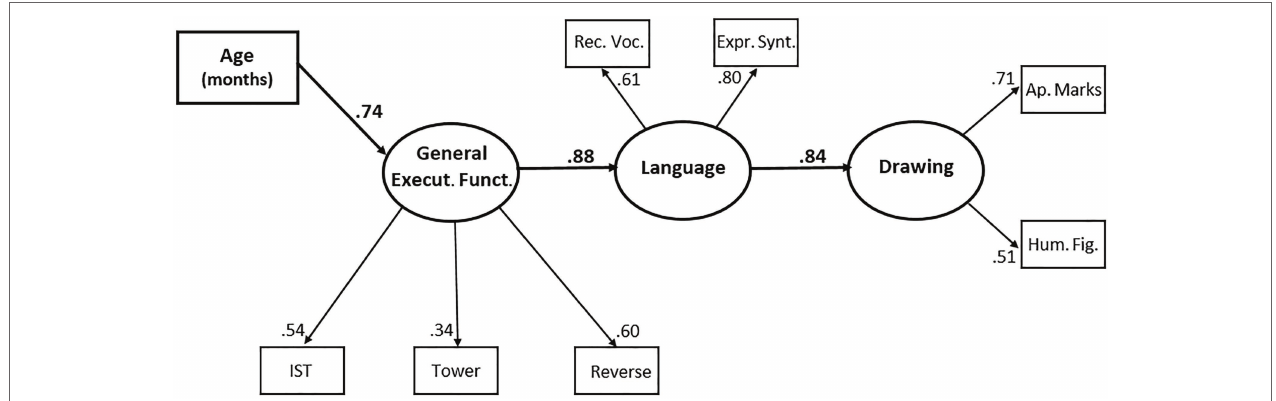
FIGURE 4 | Best-fitting structural equations model for general executive functioning, language, and drawing. Execut. Funct., executive functioning; IST, imitation sorting task; Tower, tower building; Reverse, reverse categorization; Rec. Voc., receptive vocabulary; Expr. Synt., expressive syntax; Ap. Marks, appropriate marks; Hum. Fig., human